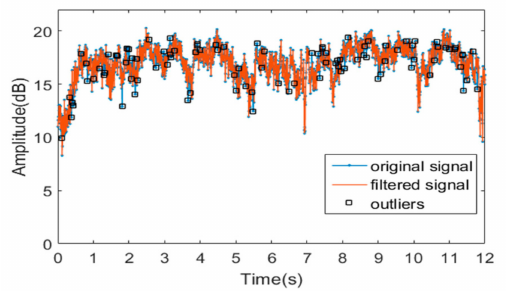
Figure 5. Outliers contained in the original